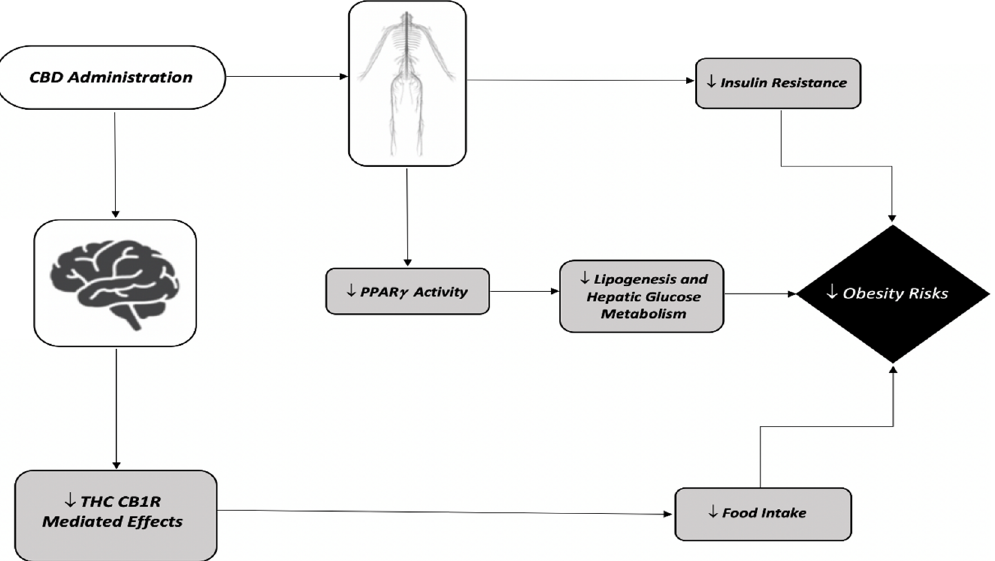
Figure 2. The mechanisms by which CBD administration affects the physiological responses to obesity risks through both the central and peripheral nervous systems. The central nervous system includes CBD inhibiting the THC-mediated CB1R effects that the drug has on obesity, specifically on food intake. The peripheral nervous system involves effects on insulin resistance along with PPAR-related activity that impacts hepatic glucose metabolism and lipogenesis levels within the adipose tissues. Symbols ↑ and ↓ denote an observed increase and decrease, respectively.